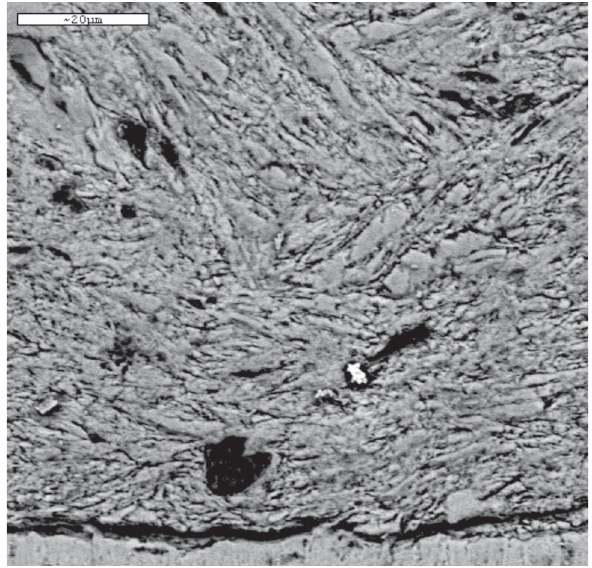
Figure 5. SEM micrograph of the microstructure of PMR bulk Sr Ca Cu O illustrating the presence of texture close to Bi 2+x 3-y y 2 8+ ∆ the mould walls.